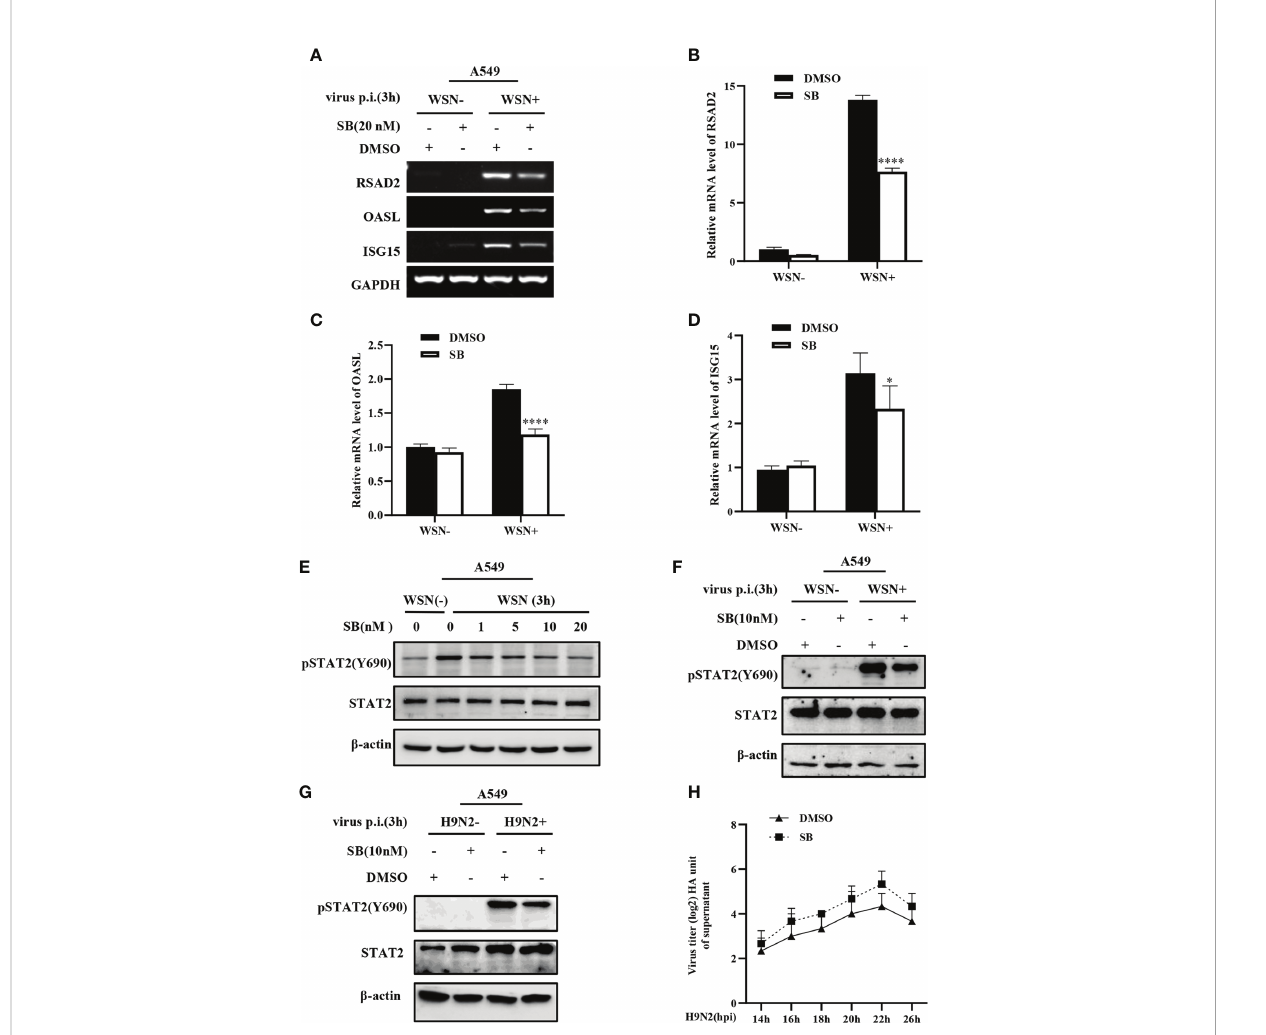
FIGURE 7 MAPK12 affects the expression of some ISGs during in fl uenza virus infection. (A – D) SB203580 (SB) pretreated- A549 cells were infected with WSN for 3 h, and the expression of antiviral genes was detected by RT-PCR (A) and RT-qPCR (B-D) . Error bars represent the mean ± SD from three independent experiments. *p < 0.05; ****p <0.0001. (E) A549 cells were pretreated with SB203580 (SB) at indicated concentrations for 20 min, then infected with WSN for 3 h, and pSTAT2 level was detected by Western blotting. Shown are representative data from